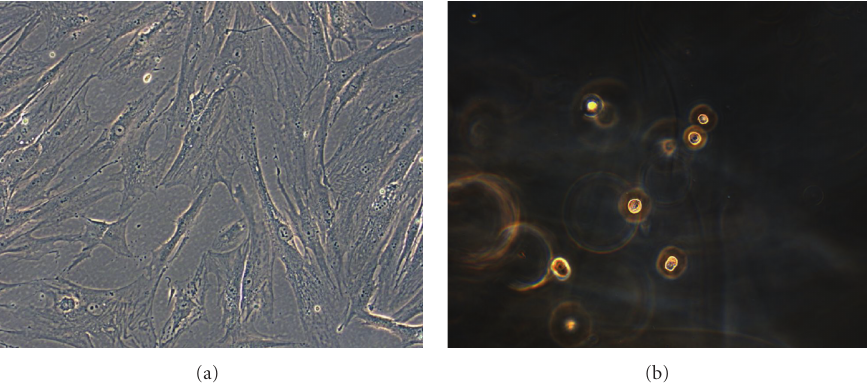
Figure 1: (a) Phase-contrast microscopy (20x objective) of PA2-E12 cultured in GM on tPS after 1 day of culture. (b) Phase-contrast microscopy (20x objective) of PA2-E12 on CMCA hydrogels after 1 day of